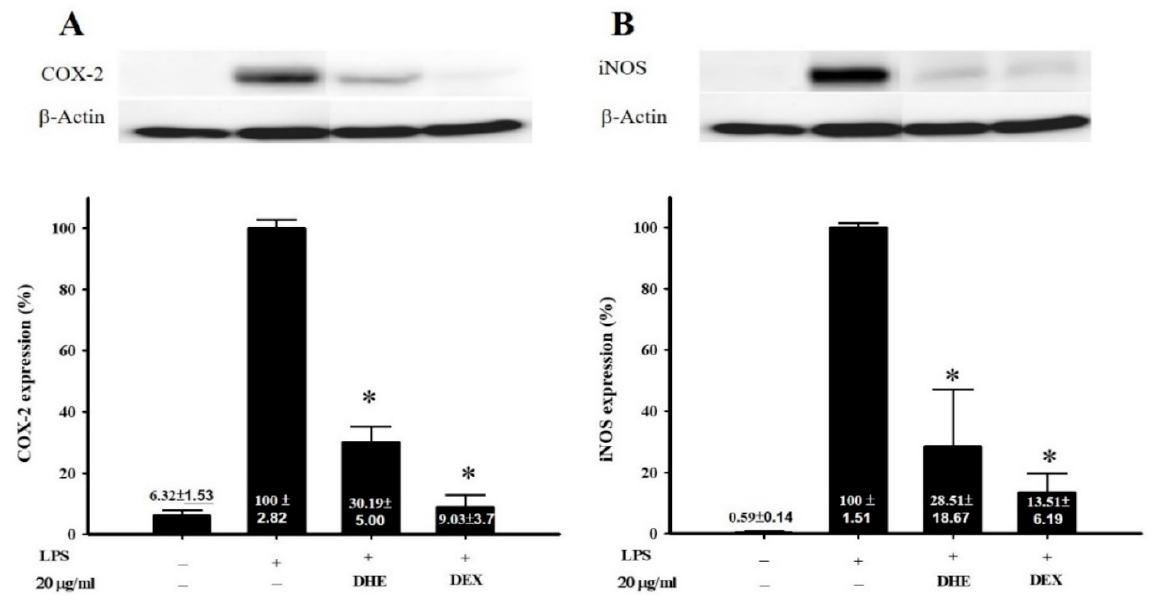
Figure 2. Anti-inflammatory activity of Diplotaxis harra extract (DHE) through inhibiting the expression of proinflammatory proteins COX-2 ( A ) and iNOS ( B ). Dexamethasone (DEX) was used as the positive. The values are mean ± S.E.M. ( n = 6). *, Significantly different from LPS-activated group ( p < 0.05).